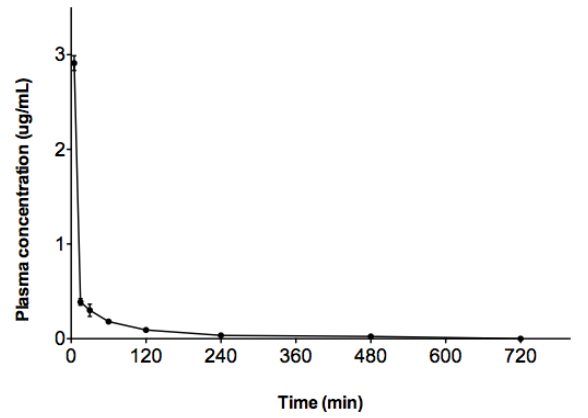
Figure 3. Graph shows the plasma level of BHMC (mean ± SEM) after i.v. injection of 10 mg/kg dosage plotted against